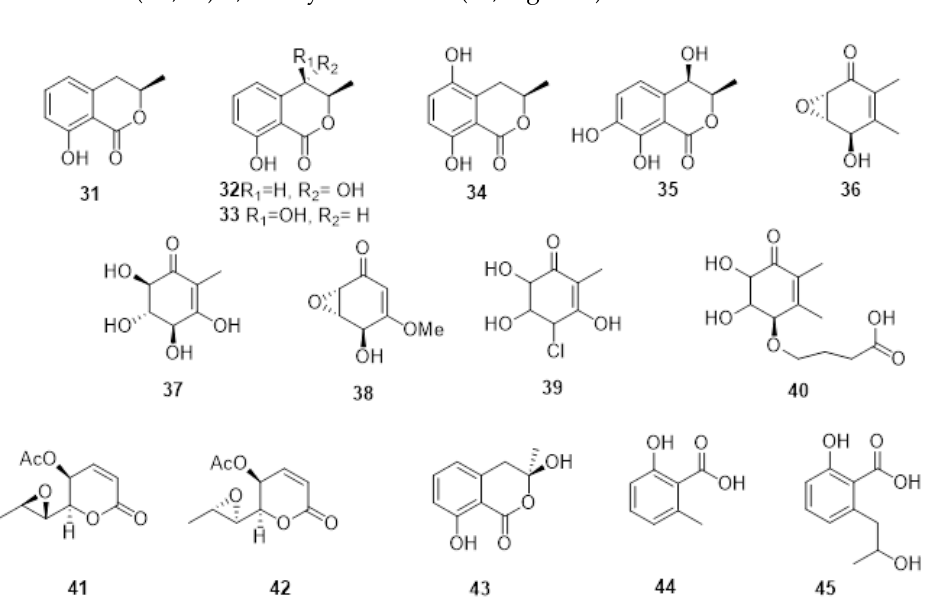
Figure 4. Structure of: ( R )-mellein ( 31 ), (3 R ,4 R )-and (3 R ,4 S )-4-hydroxy melleins ( 32 , 33 ), 5-hydroxymellein ( 34 ), (3 R ,4 R )-4,7- dihydroxy mellein ( 35 ), (+)-terremutin ( 36 ), (+)-terremutin hy- drate ( 37 ), (+)-epi-sphaeropsidone ( 38 ), (-)-4-chloro-terremutin hydrate ( 39 ), (+)-4—hydroxysuccinate- terremutin hydrate ( 40 ), (6 R ,7 R )-asperlin ( 41 ), (6R,7S)-dia-asperlin ( 42 ), (R)-3-hydroxymellein( 43 ), 6-methyl-salicylic acid ( 44 ) and 2-hydroxypropyl salicylic acid ( 45